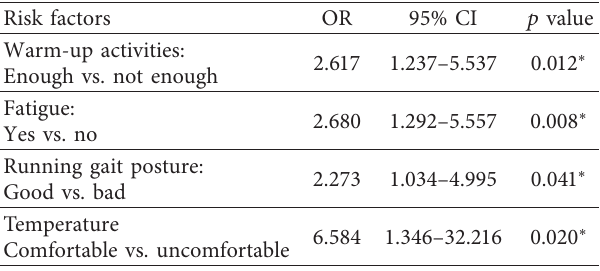
Table 3: Multivariate regression model (forward stepwise) for LBP in